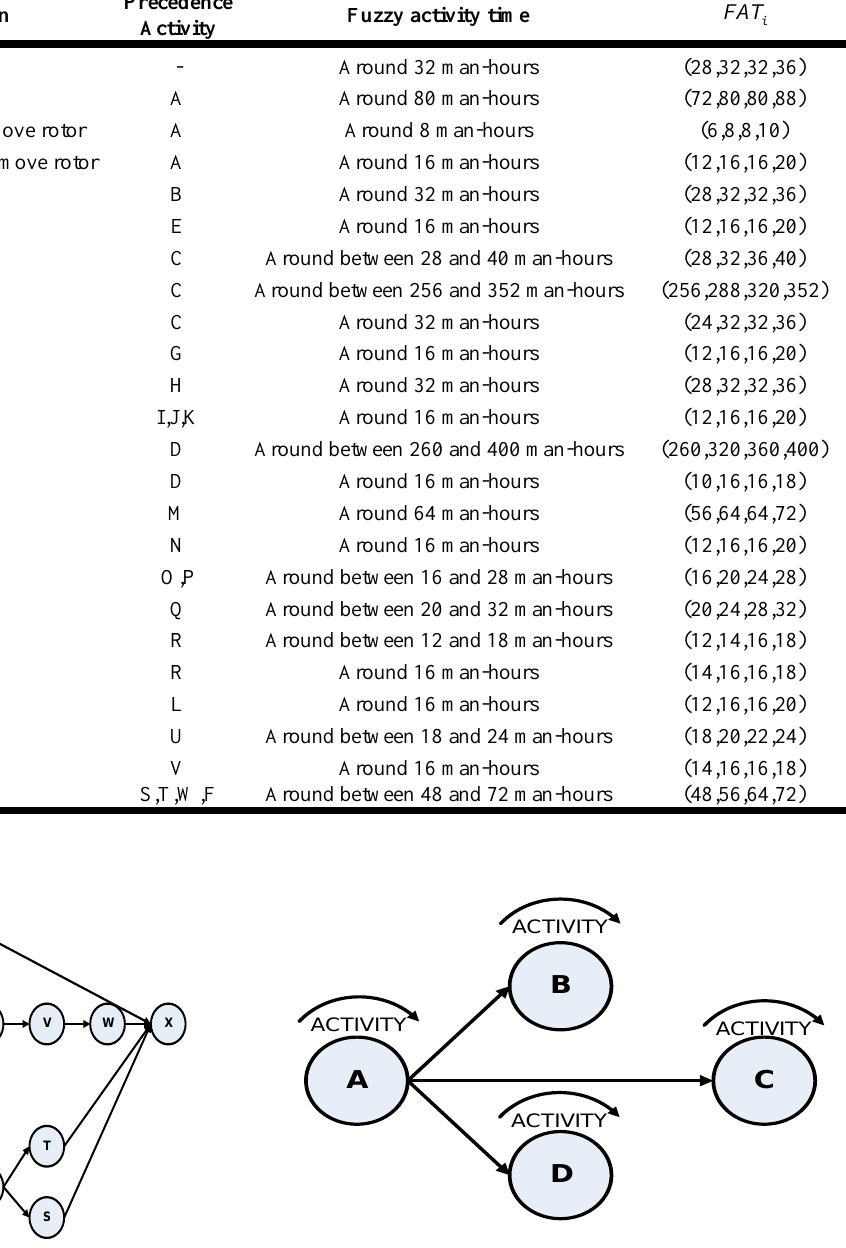
Figure 2. B, C and D cannot begin until A has been completed .